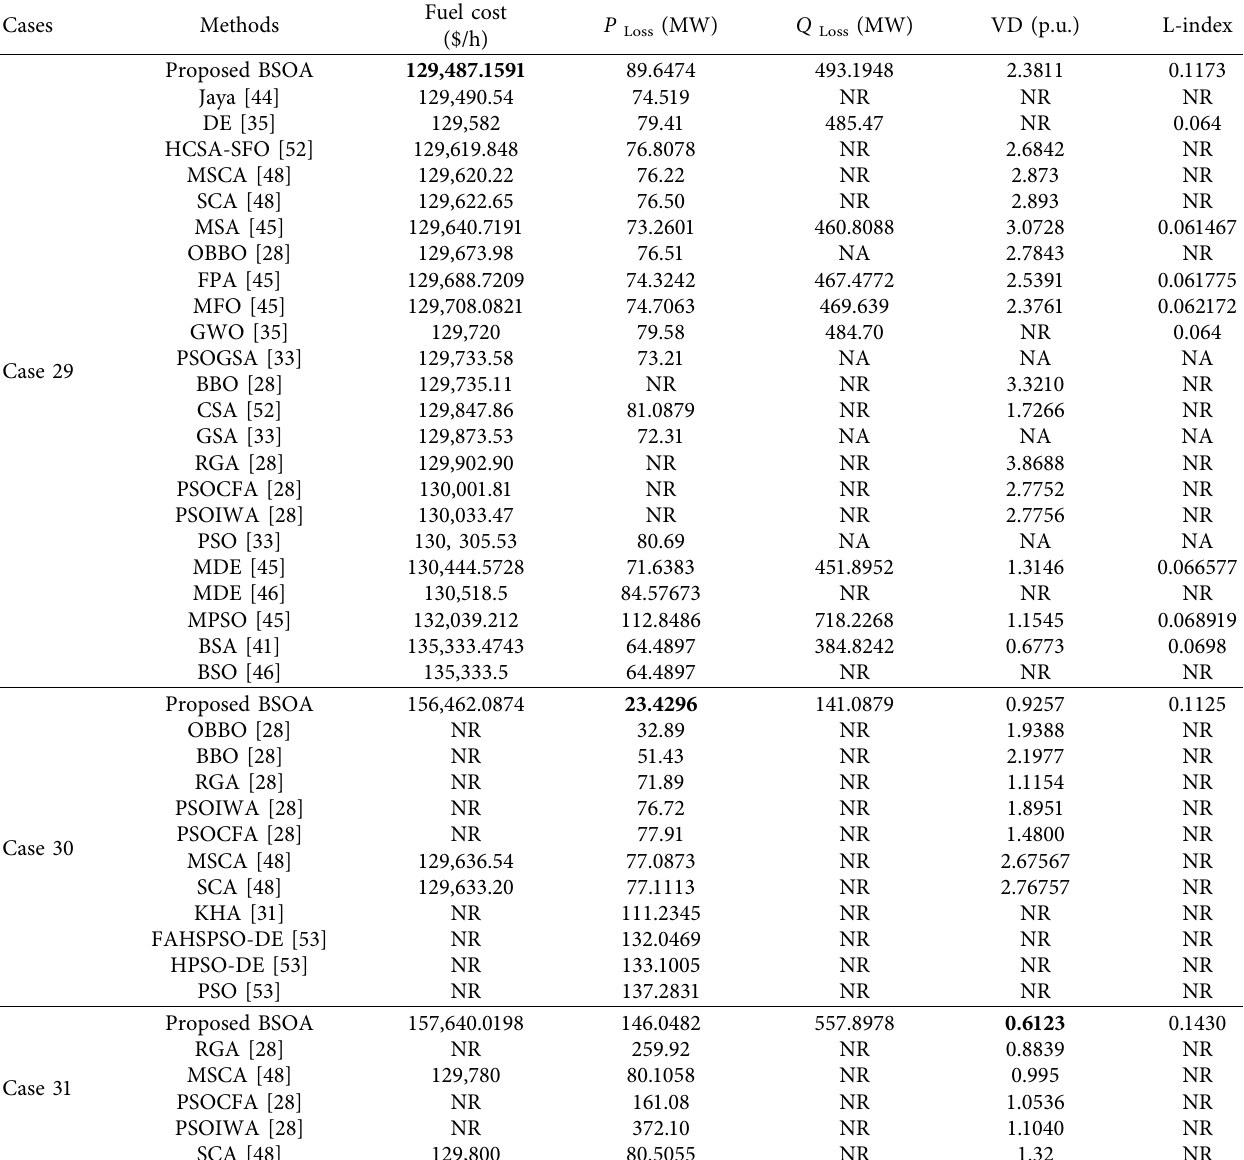
Table 14: Comparison of the proposed BSOA method with previous recent studies for single-objective cases (Case 29 to Case 31) in the IEEE 118-bus system.